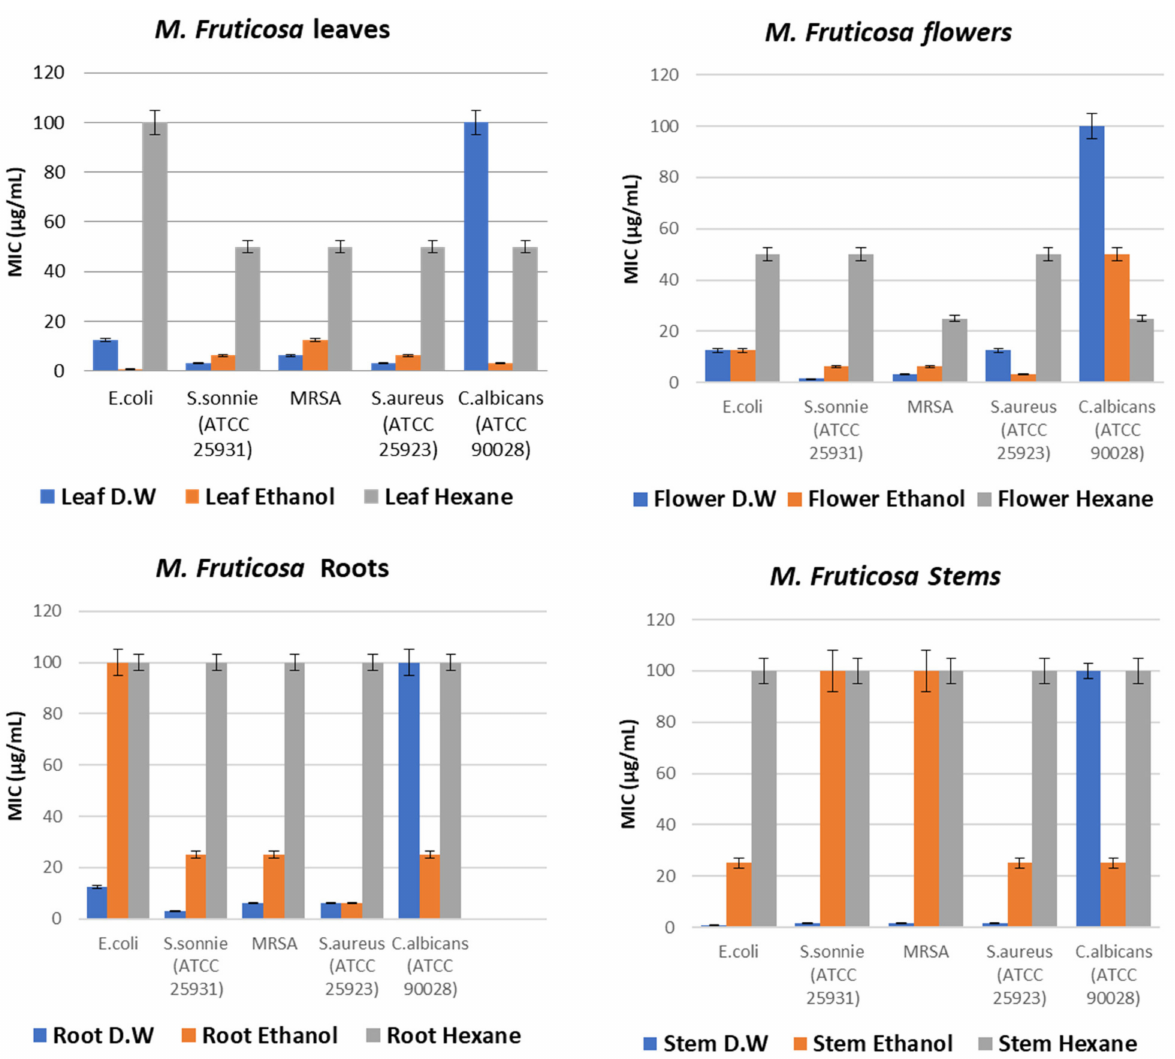
Figure 3. Minimum inhibitory concentration (MIC) ( µ g/mL) of botanical parts (leaves, flowers, stems, and roots) of M. fruticosa extracted with water, ethanol, and hexane against different pathogens. The bars represent means of two replicates ± standard